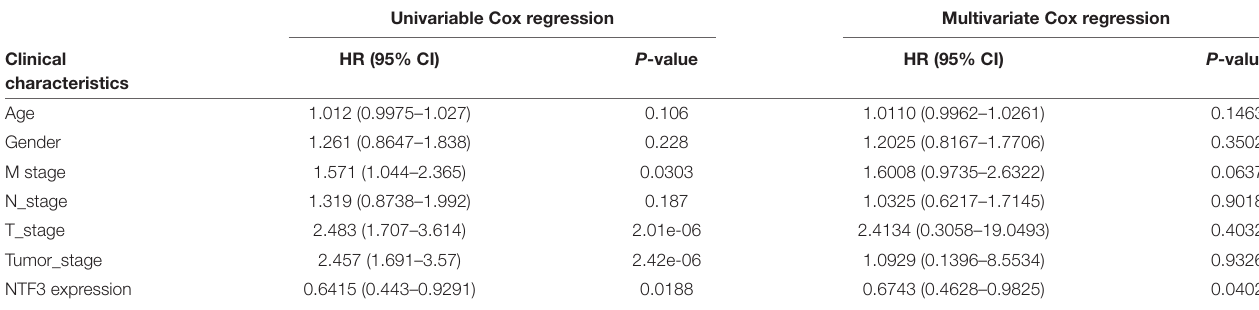
TABLE 2 | Association of overall survival and clinicopathologic characteristic in